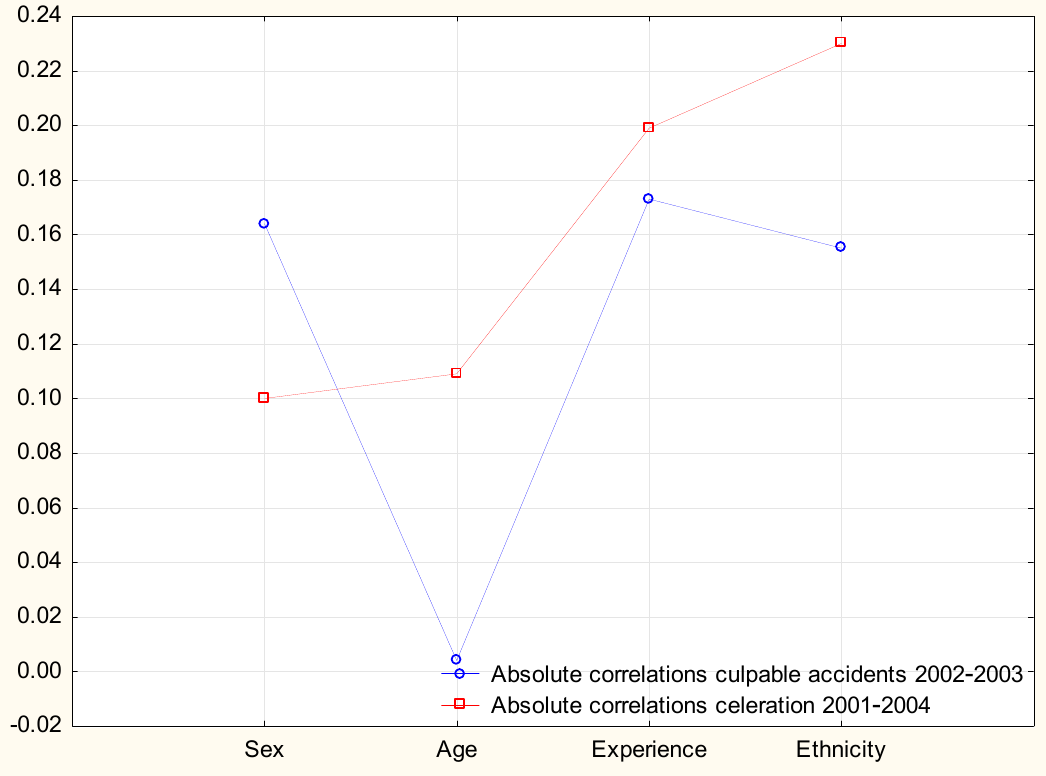
Figure 1. The correlations of sex, age, experience, and ethnic origin with culpable accidents and celeration. N = 259.